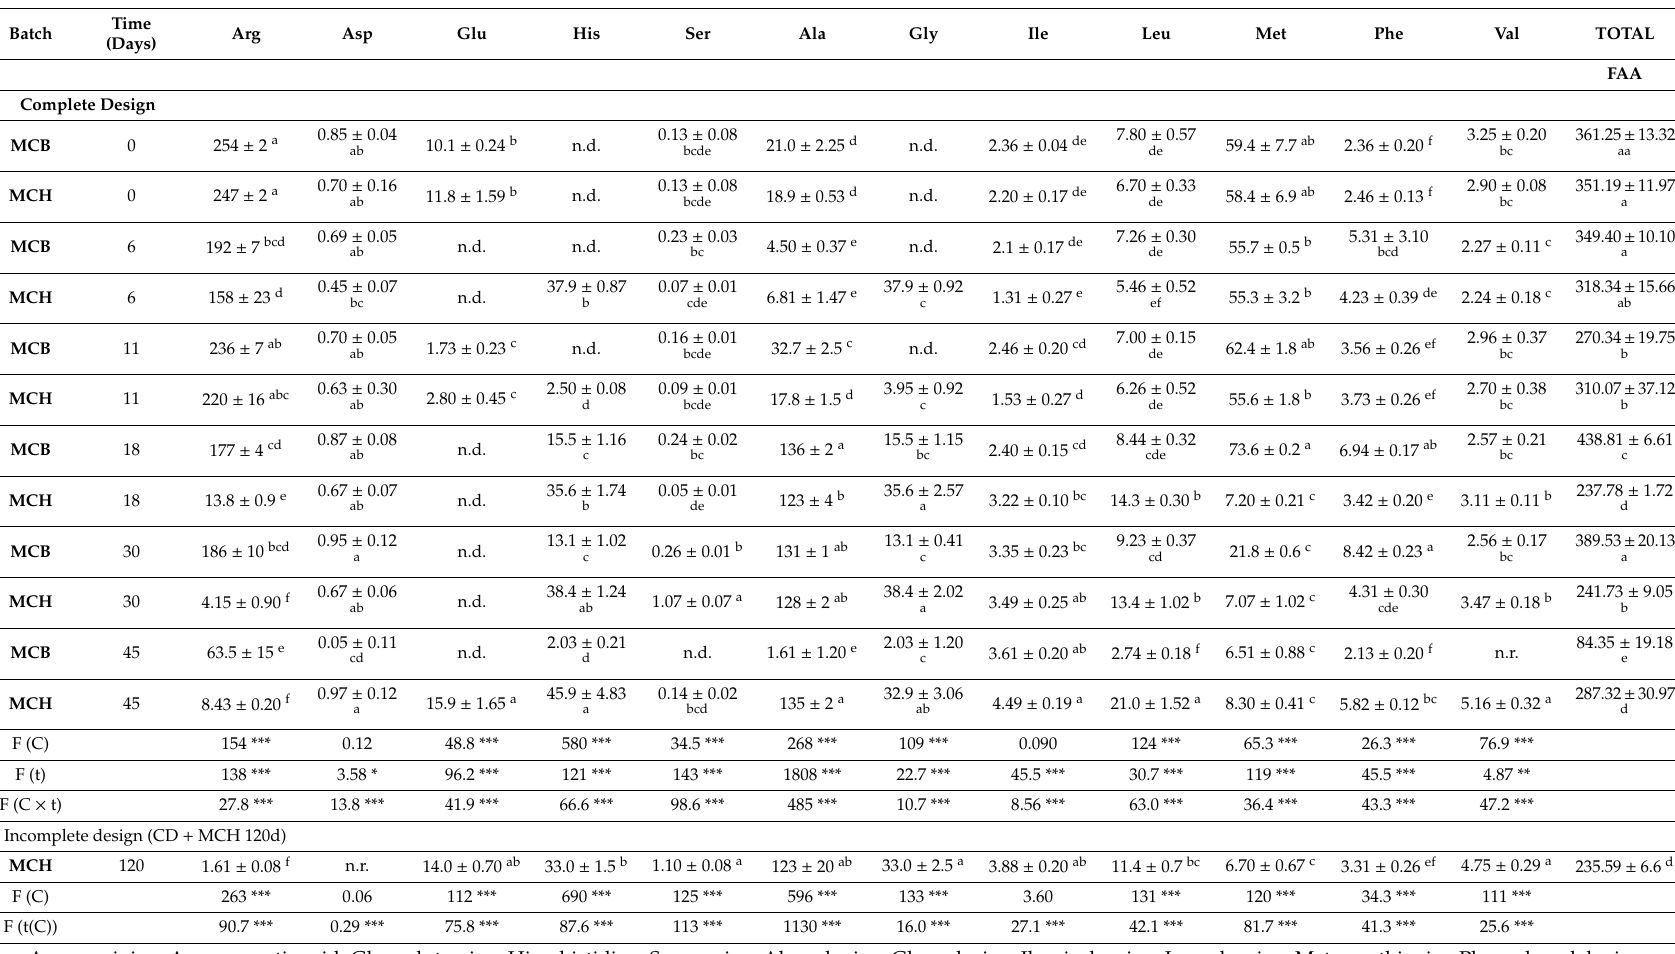
Table 2. Free amino acids content (mg / 100 g meat) in “ Mortadella di Campotosto ”-like sausages produced with beef (MCB) and hog (MCH) casings over time.